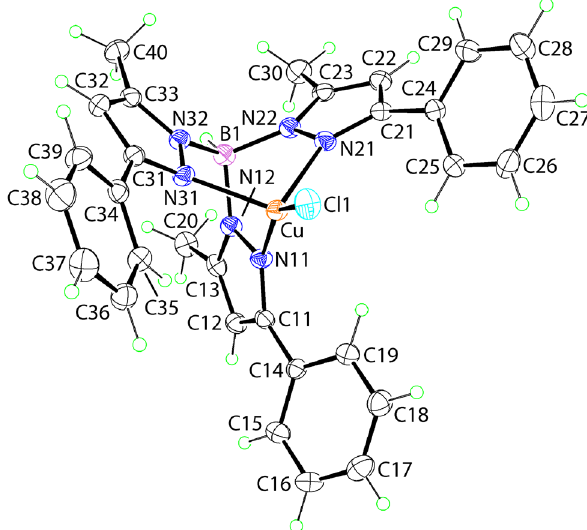
Table  : Data collection and